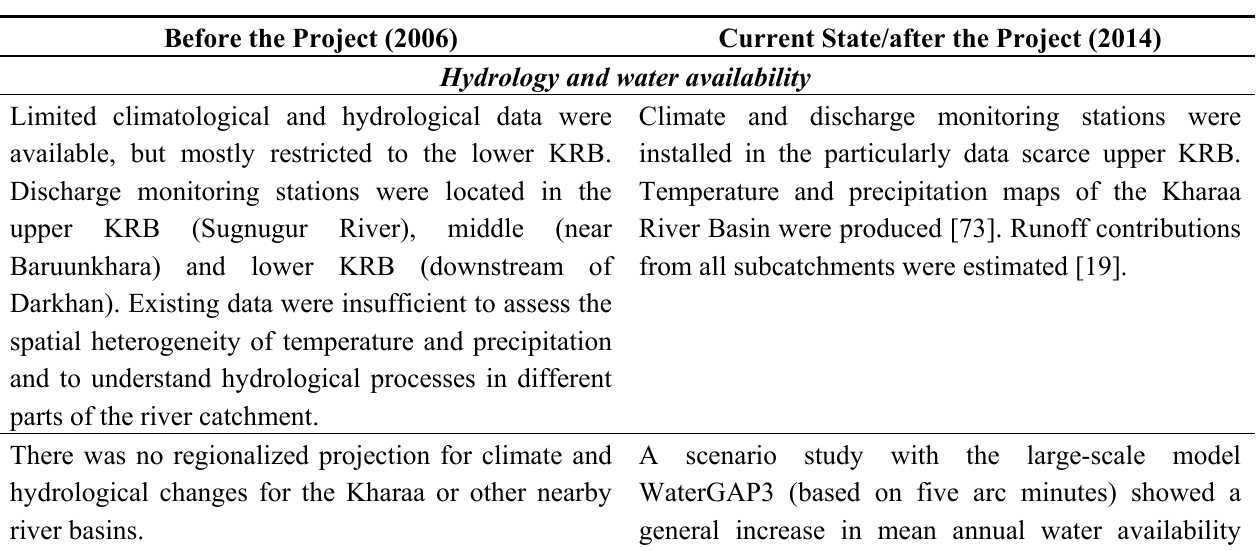
Table 2. Data situation before and after the Integrated Water Resources Management in Central Asia—Model Region Mongolia (IWRM MoMo)